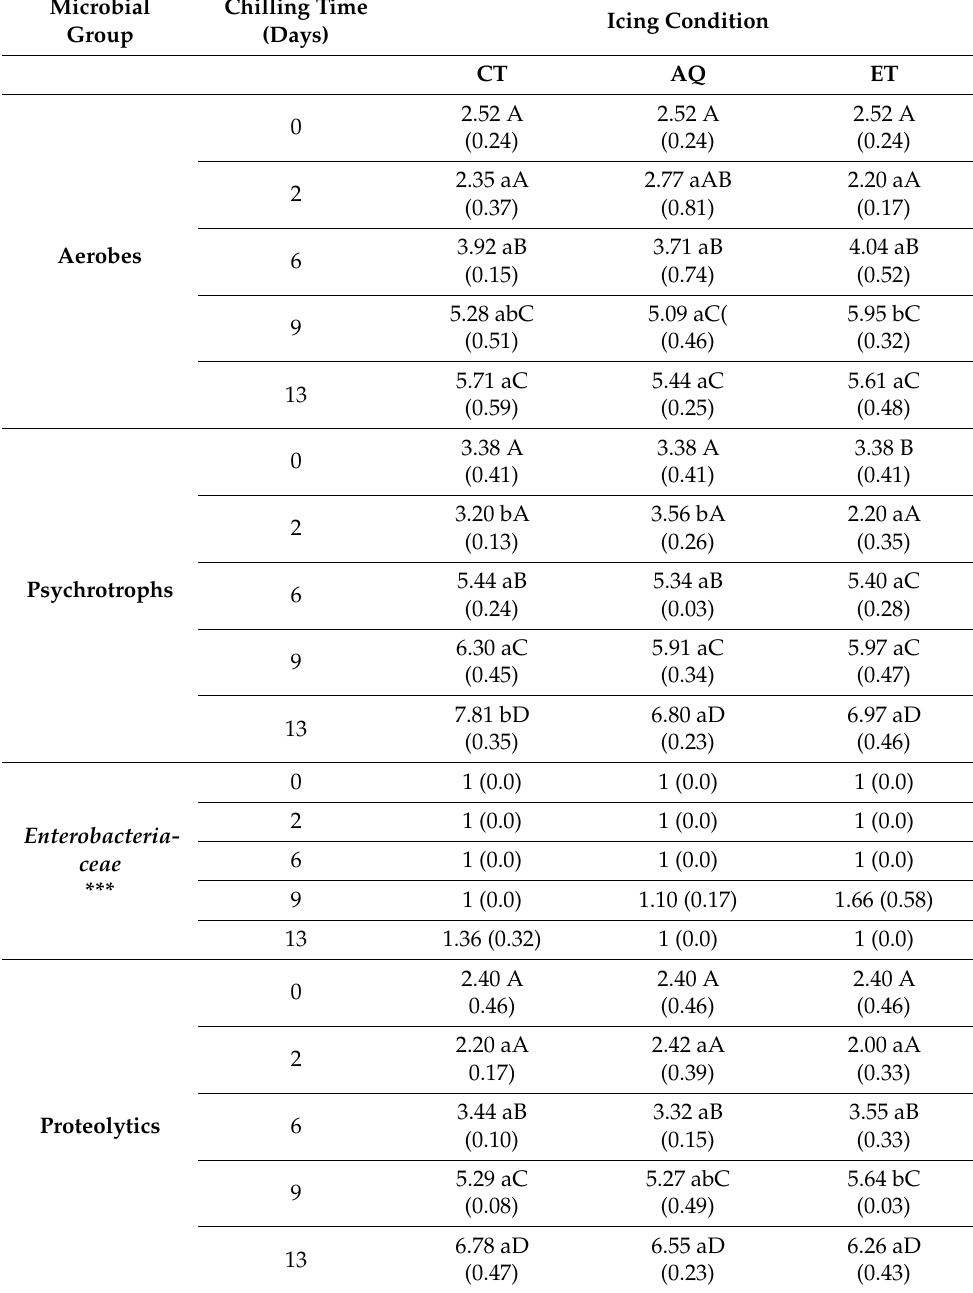
Table 1. Evolution of microbial development (log CFU · g − 1 ) * in chilled hake subjected to different icing conditions